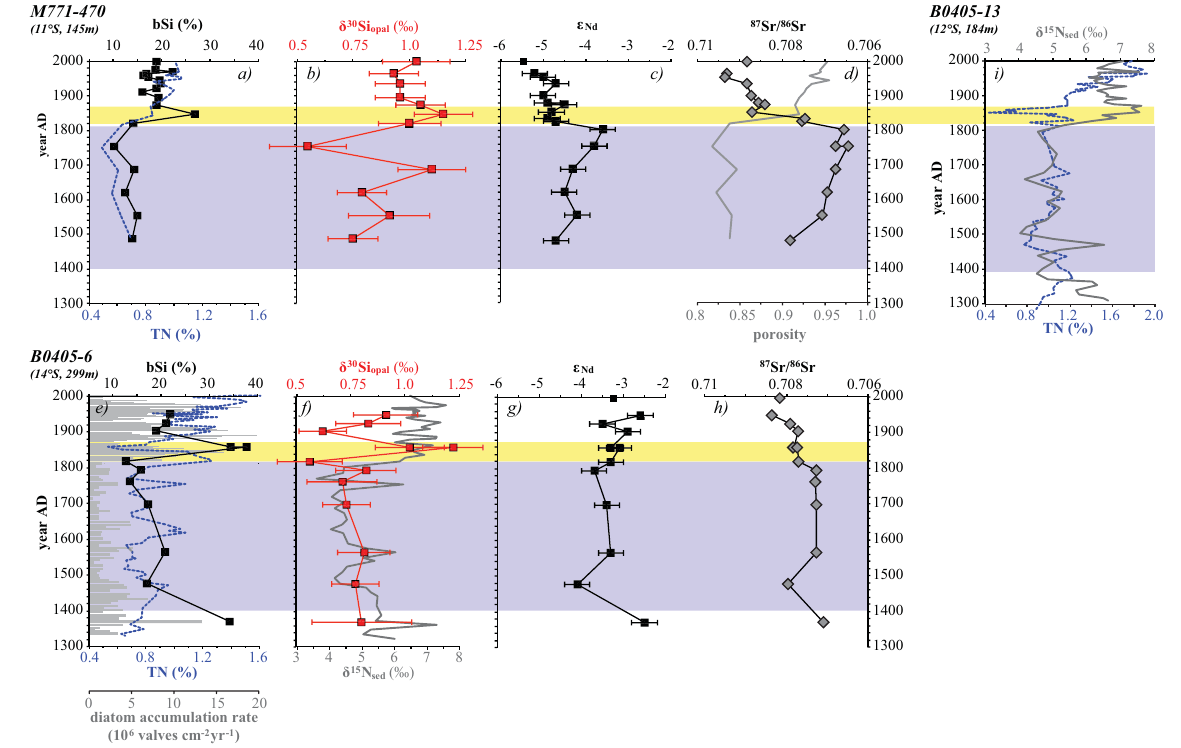
Figure 2. Downcore records for core M771-470 (upper panel) and core B0405-6 (lower panel). The blue and yellow shadings indicate the age range of the LIA and the transitional period, respectively. (a, e) bSi concentration (black squares), (a, e, i) total N concentration (dashed blue curve), (e) diatom accumulation rate (grey bars) (Gutiérrez et al., 2009), (b, f) δ 30 Si opal (red squares), (f) bulk δ 15 N sed (grey curve) (Gutiérrez et al., 2009), (c, g) ε Nd detritus (black squares), (d, h) 87 Sr / 86 Sr detritus (grey diamonds; x axis is inverted), (d) sediment porosity (grey curve). Error bars represent 2 σ (sd) external reproducibilities of repeated standard or sample measurements. For comparison, (i) shows the total N content and δ 15 N sed of core B0405-13 (Gutiérrez et al.,